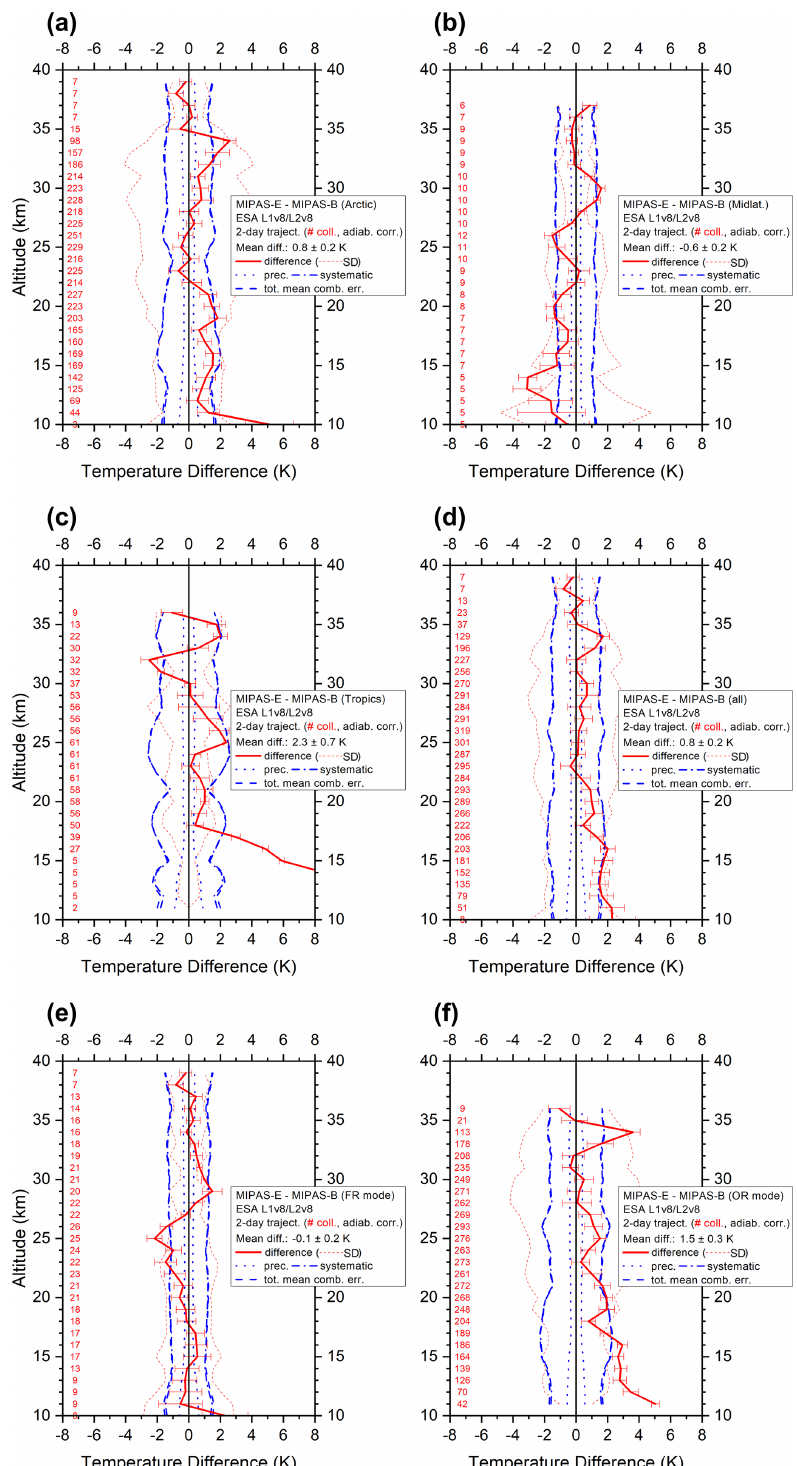
Figure 2. Mean temperature difference (red solid line) of all trajectory match collocations (red numbers) between MIPAS-E and MIPAS-B, including standard deviation (red dotted lines) and standard error of the mean (plotted as error bars). Precision (blue dotted lines), systematic (blue dash-dotted lines), and total (blue dashed lines) mean combined errors are shown too. Arctic (a) , midlatitude (b) , tropics (c) , all FR plus OR (d) , FR mode (e) , and OR mode (f) collocations. For details, see